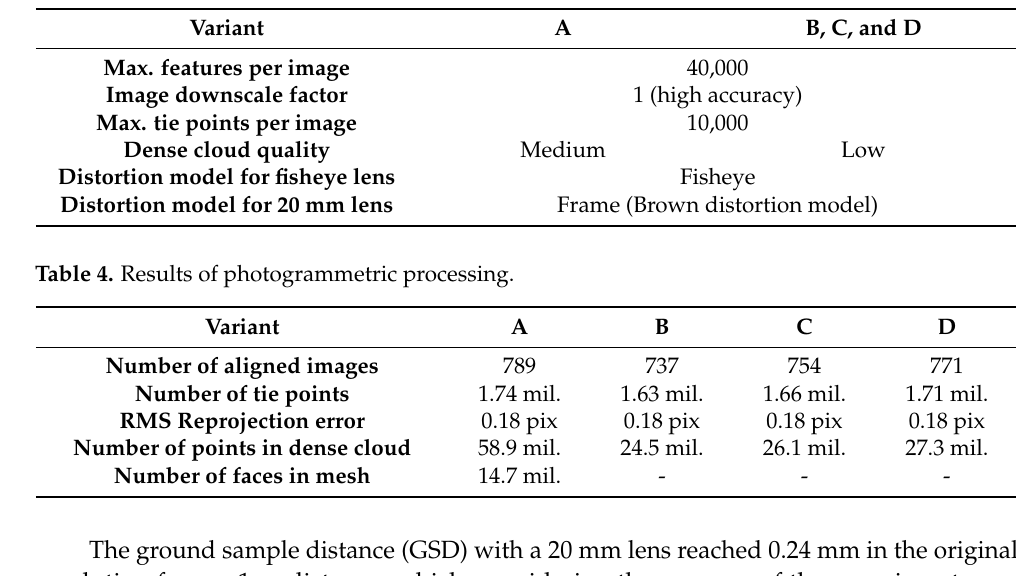
Table 3. Settings for photogrammetric processing.